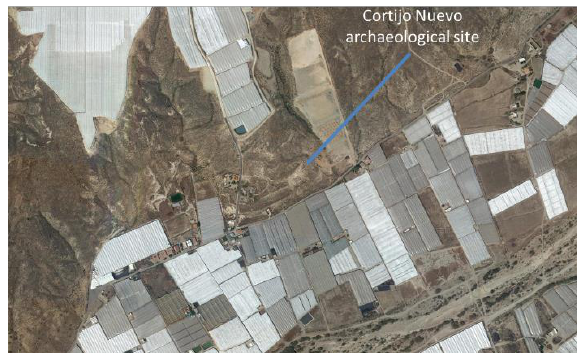
Figure 1. Current state of the study area, in a greenhouse intensive agriculture zone